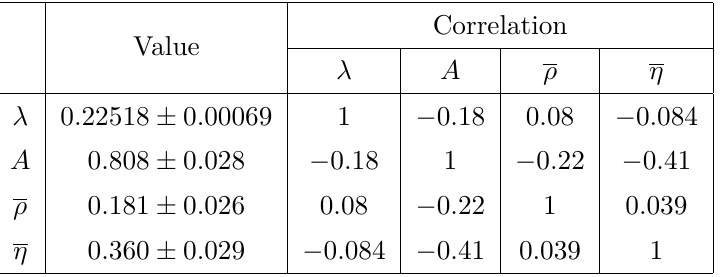
Table 5 . Wolfenstein parameters obtained from a fit to the CKM entries in table 4.